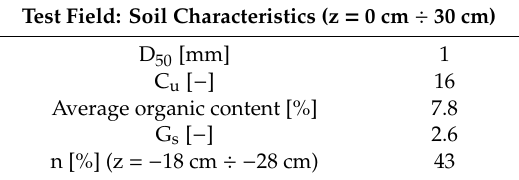
Table 2. Characteristics of the test-field soil (the upper 30 cm). D 50 : mean grain diameter (50% sieve